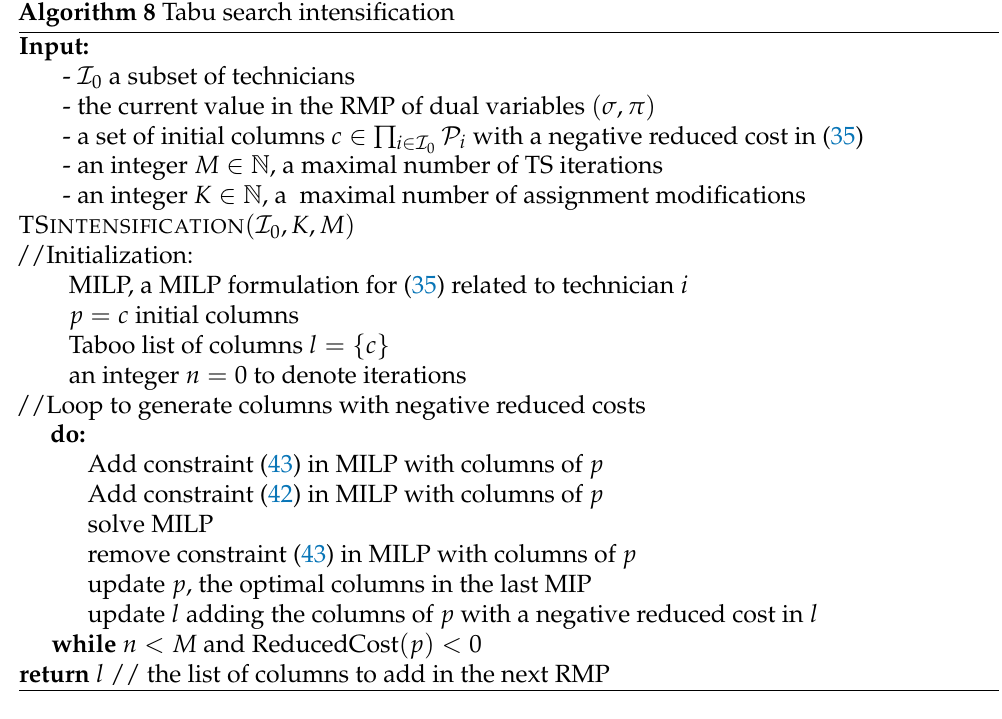
Algorithm 8 Tabu search